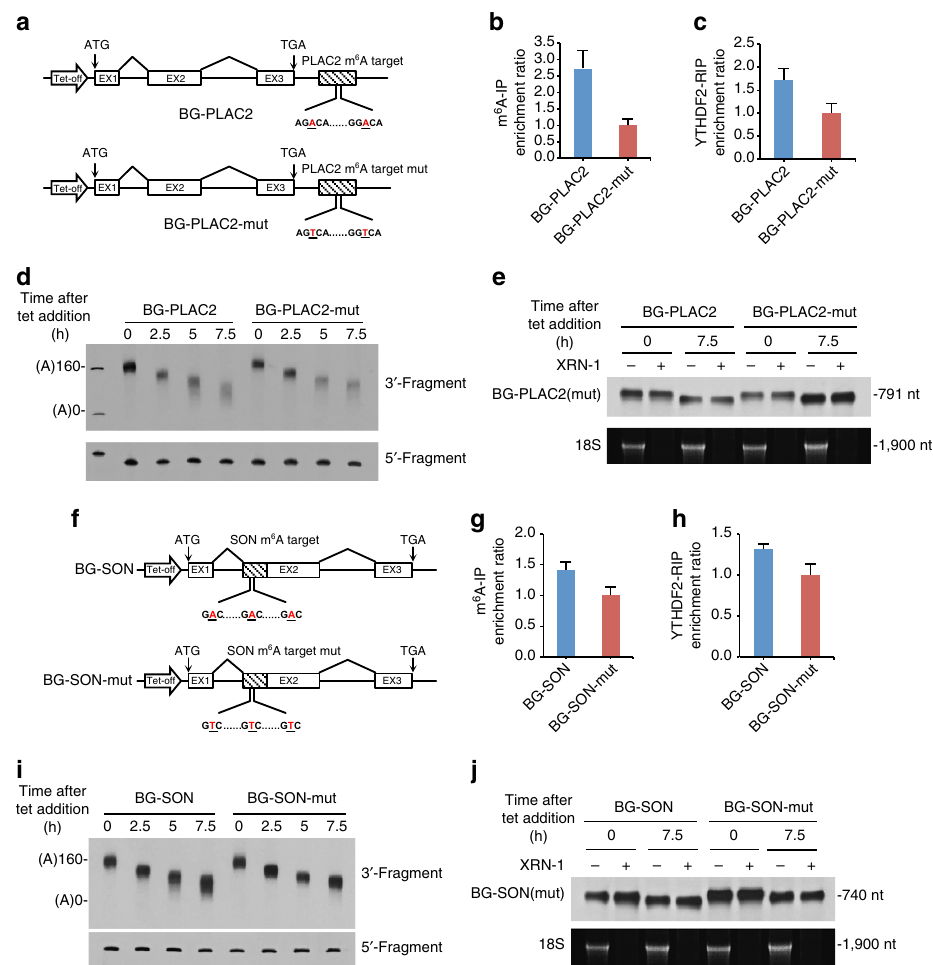
Figure 1 | m 6 A modification promotes deadenylation of RNAs. ( a ) The reporter constructs of BG-PLAC2 and BG-PLAC2-mut. A 135-nt fragment from lncRNA PLAC2 was inserted into the 3 0 -UTR of the BG reporter (BG-PLAC2). Blank box indicate the open reading frame (ORF). Striped box indicate the inserted DNA fragment. BG-PLAC2-mut is identical to BG-PLAC2, except that the two adenosines (underlined) within the m 6 A motifs were mutated to thymidines. ( b ) The m 6 A-IP enrichment ratio of BG-PLAC2 relative to BG-PLAC2-mut. ( c ) The YTHDF2-RIP enrichment ratio of BG-PLAC2 relative to BG- PLAC2-mut. The RIP assay was performed using anti-FLAG M2 antibody with HeLa-tTA cells that stably express FLAG-tagged YTHDF2. ( d ) Deadenylation assay of BG-PLAC2 and BG-PLAC2-mut. The brief removal of tetracycline (tet) from the culture medium generated a homogenous population of BG mRNAs that underwent synchronous decay. RNA samples were collected at the indicated time intervals and subjected to site-specific cleavage by RNase H to produce 3 0 - and 5 0 -BG mRNA fragments. RNA samples were then separated by electrophoresis and detected by northern blotting. ( e ) Retention of the 5 0 -cap on BG-PLAC2 and BG-PLAC2-mut undergoing deadenylation. The BG-PLAC2 and BG-PLAC2-mut RNA samples collected at 0 and 7.5h from d were treated or not treated with the 5 0 -phosphate-dependent exonuclease XRN-1. 18S rRNA, which lacks a 5 0 -cap, served as a positive control for XRN-1 activity. ( f – j ) The same experiments as in a – e for BG-SON and BG-SON-mut. Error bars, mean ± s.d., n ¼ 3, biological replicates.